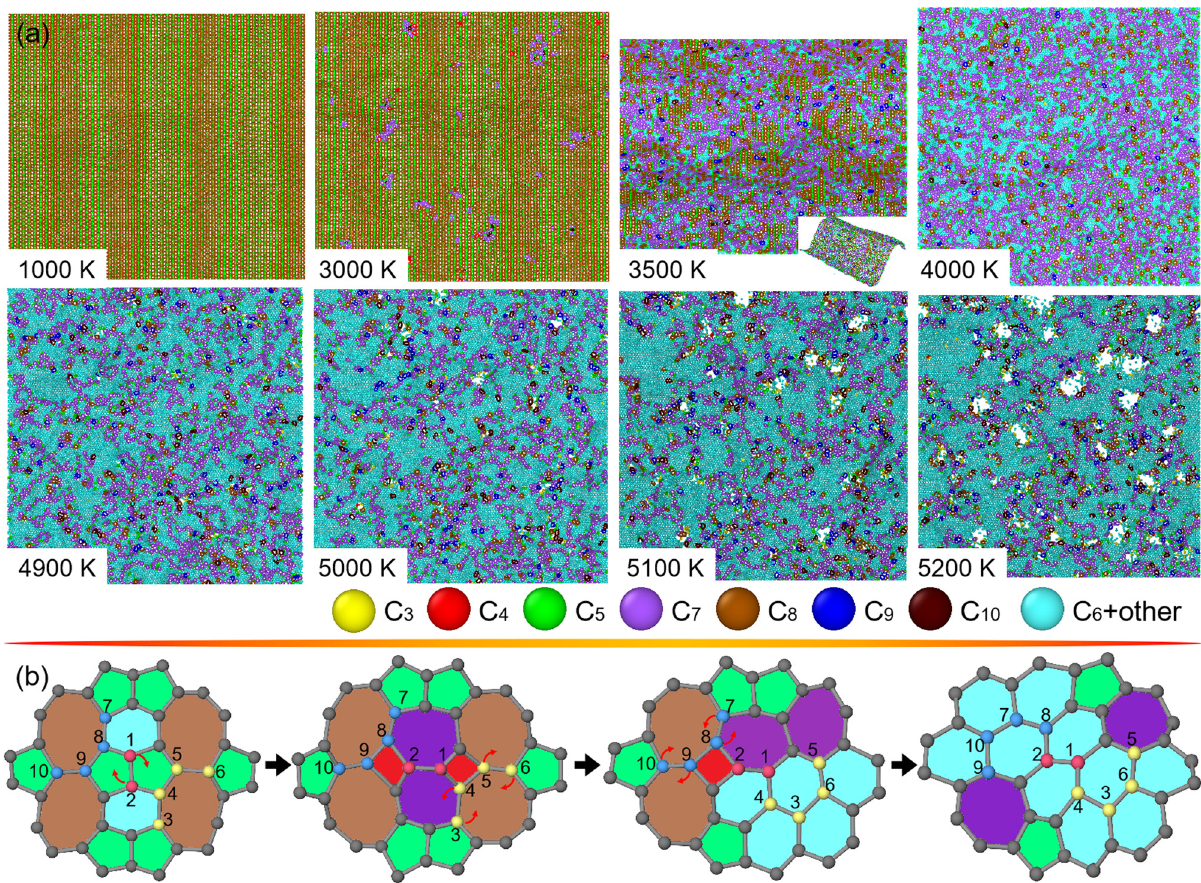
Figure 7: Structural changes in penta - hexoctite under heating. ( a ) Top - viewed snapshots of penta - hexoctite at T from around 1,000 – 5,200 K. For eye - catching the microstructural changes, carbon atoms in polygonal rings from trigon to decagon are color - painted. ( b ) Atomic illustration of nucleation of hexagons from pentagons, hexagons, and octagons in a zoomed - in region of penta - hexoctite. Speci fi cally, carbon atoms are number - ranked and arrows are marked for explaining the origins of microstructural